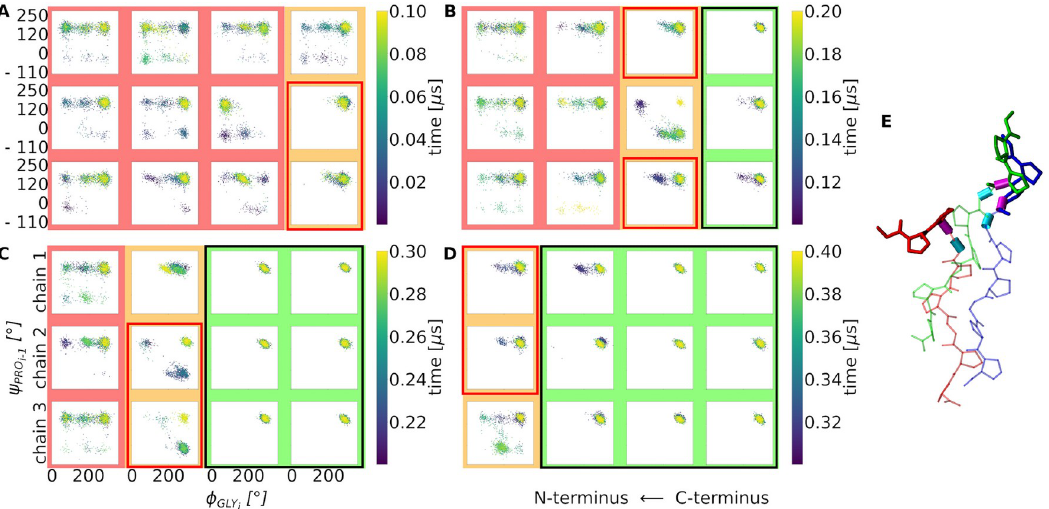
Fig 3. Sequential collagen folding process in terms of successive dihedral angle transitions. (A-D) 2D-Ramachandran type plot of the most flexible backbone dihedral angles ( ϕ of Gly i and ψ of neighboring Pro i-1 ) in each chain of the triple helix during subsequent time periods of a folding simulation (simulation time increases from A to D). The already folded part of the triple helix, starting from the right side (C-terminus) is framed in black and highlighted by a green background (in A-D) with both dihedral angles sample the native conformation in the upper right corner of the plots. In contrast, dihedral angles cover a broader distribution in the still unfolded, disordered segments of each chain (red background). The part in between (orange) indicates an intermediate state, where two chains adopt already a native dihedral angle configuration while one is still in a non-native configuration. The process is repeated in a step-wise manner in A-D in the direction of the N-terminus of the chains. (E) Simulation snapshot indicating a partially folded triple helix with two chains overhanging by three residues in near-native geometry (blue and green) and one strand with the corresponding three residues still unfolded (red sticks). The rotatable bonds that define the ϕ of Gly i and ψ of Pro i-1 are shown as cyan and magenta cylinders, respectively.